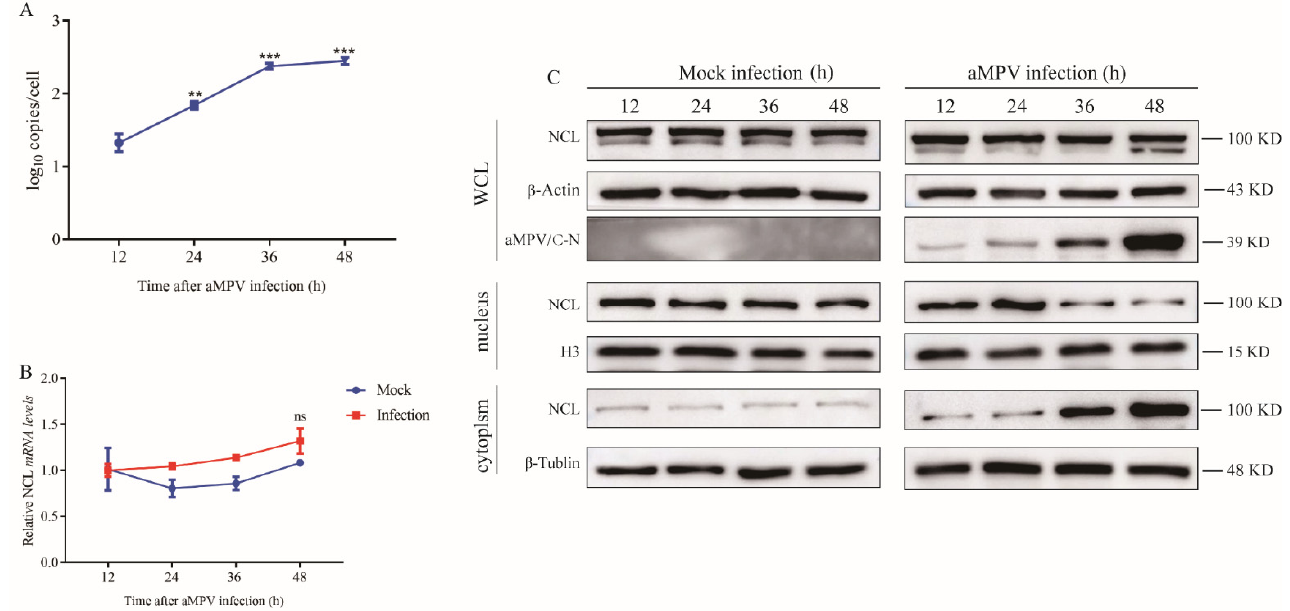
Figure 1. aMPV/C infection-induced cytoplasmic re-localization of NCL from the nucleus. Vero cells were infected or not with aMPV/C, and samples were harvested at 12, 24, 36, and 48 h following infection or non-infection. ( A ) aMPV/C RNA loads are displayed according to the number of hours following infection with aMPV/C, represented in copies/mL. ( B ) qRT-PCR analysis was used to identify relative quantities of NCL RNA in different samples obtained at the indicated time. ( C ) Western blot analysis was utilized to determine the total level of NCL expression, as well as the cytoplasmic and nuclear abundance of different samples obtained at the specified times. H3, β -actin, or β -tublin was used as an internal control. All data from three different experiments were shown as mean SD. ** p < 0.01, *** p < 0.001 were considered statistically significant; ns, not